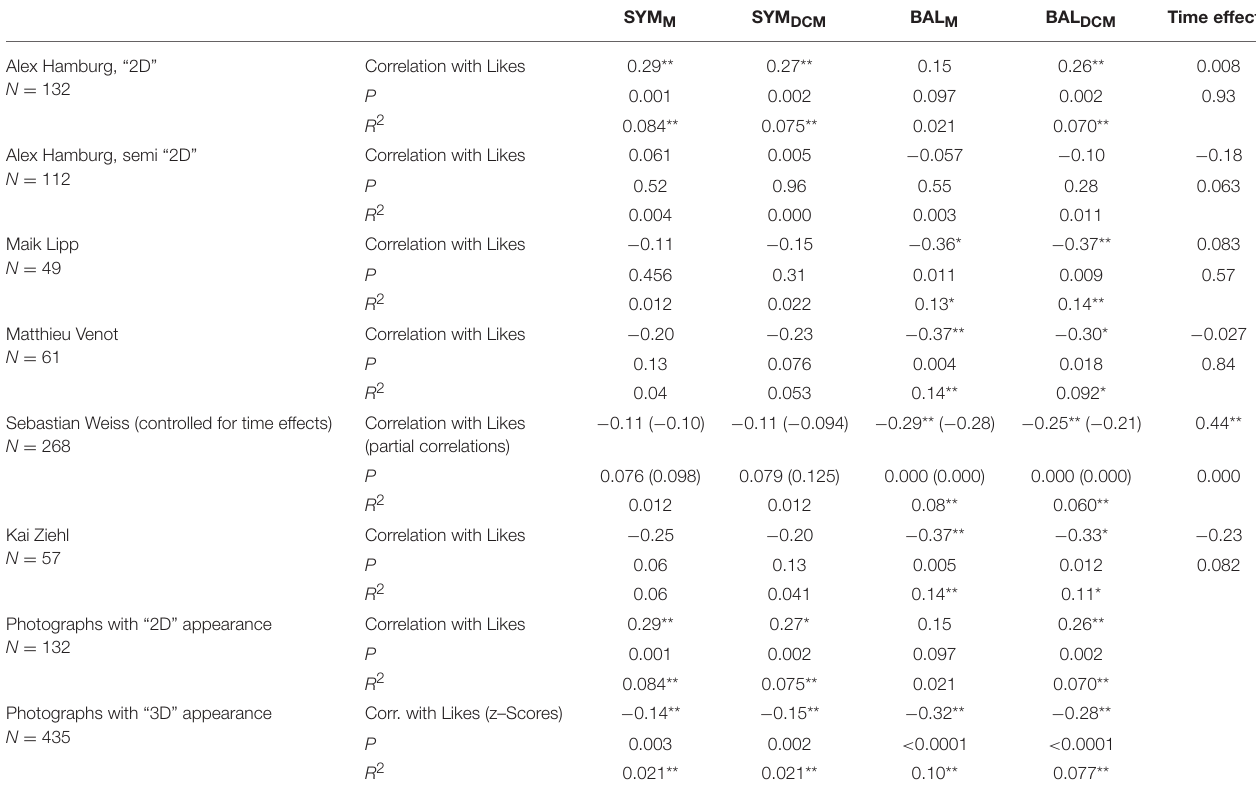
TABLE 7 | Correlation analysis per photographer, Pearson correlation coefficients, and R 2 .